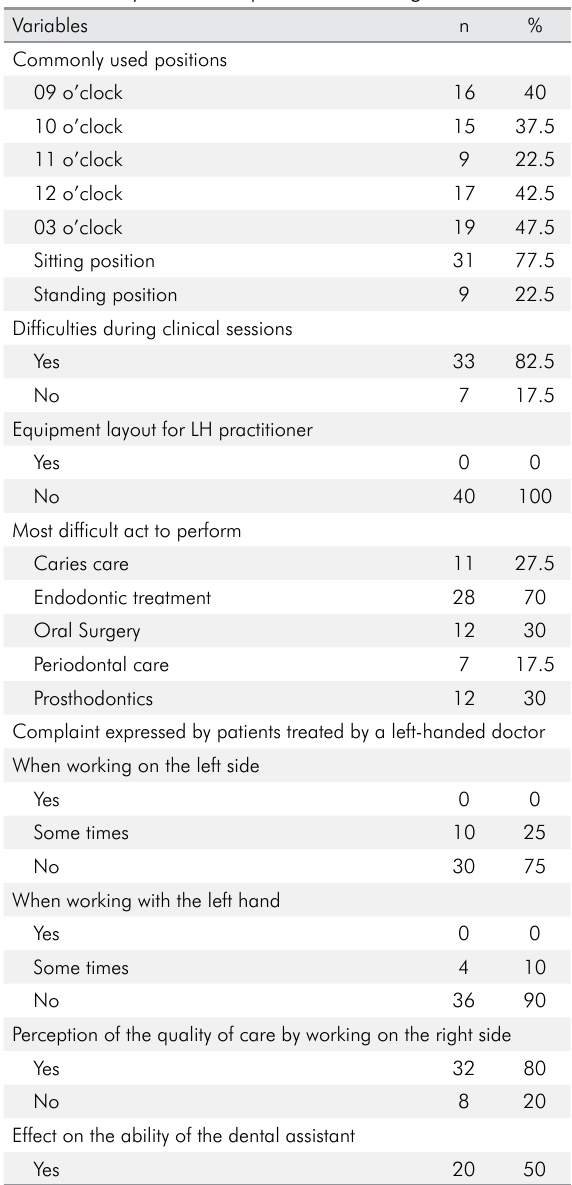
Table 2. Analysis of clinical practices and the difficulties encountered by left-handed practitioners during clinical